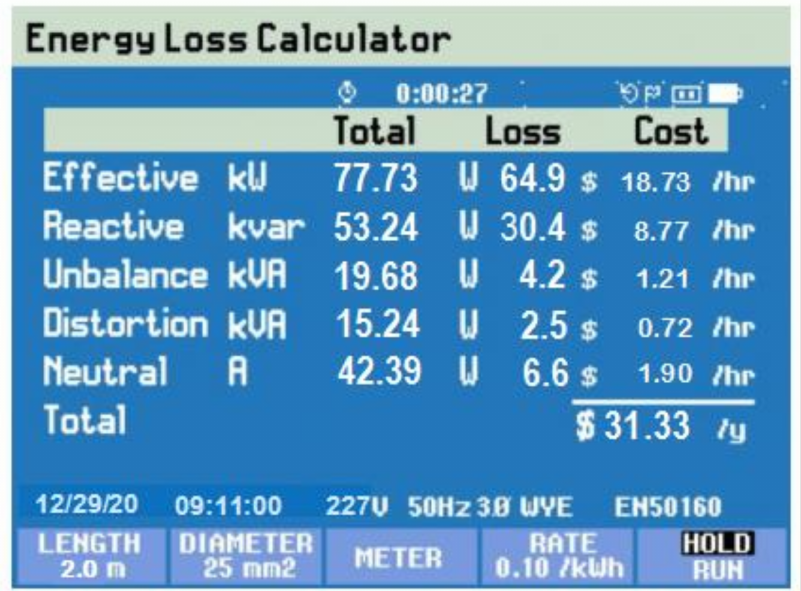
Figure 1. The Energy Loss Calculator screen from the Fluke 435 Series II